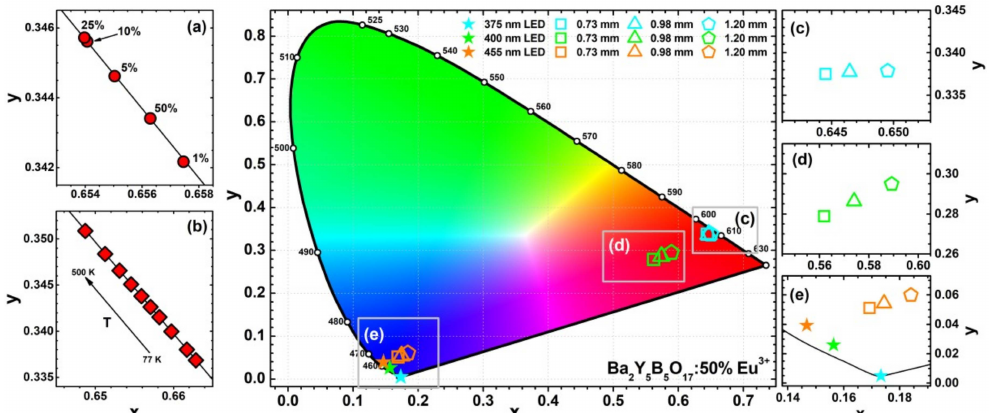
Figure 8. Magnified sections of CIE 1931 colour space diagram showing colour coordinates of Ba 2 Y 5 B 5 O 17 :Eu 3 + samples as a function of Eu 3 + concentration ( λ ex = 394 nm) ( a ) and temperature ( λ ex = 394 nm) ( b ) for Ba 2 Y 5 B 5 O 17 :50%Eu 3 + specimen. Enlarged areas ( c ), ( d ), and ( f ) show colour coordinates of Ba 2 Y 5 B 5 O 17 :50%Eu 3 + ceramic disks (0.73, 0.98, and 1.20 mm in thickness) excited with 375, 400, and 455 nm emitting LEDs, respectively.